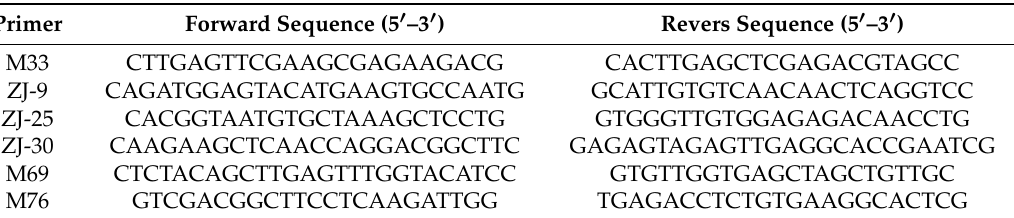
Table 1. Polymorphic markers for gene mapping.